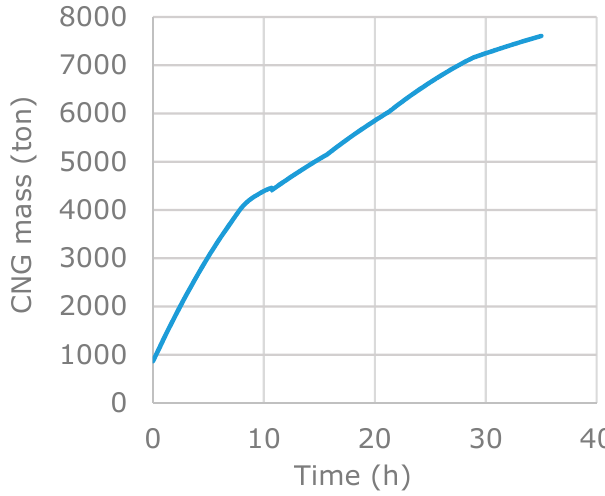
Figure 9. Mass of CNG in the pressure vessels (adiabatic loading).